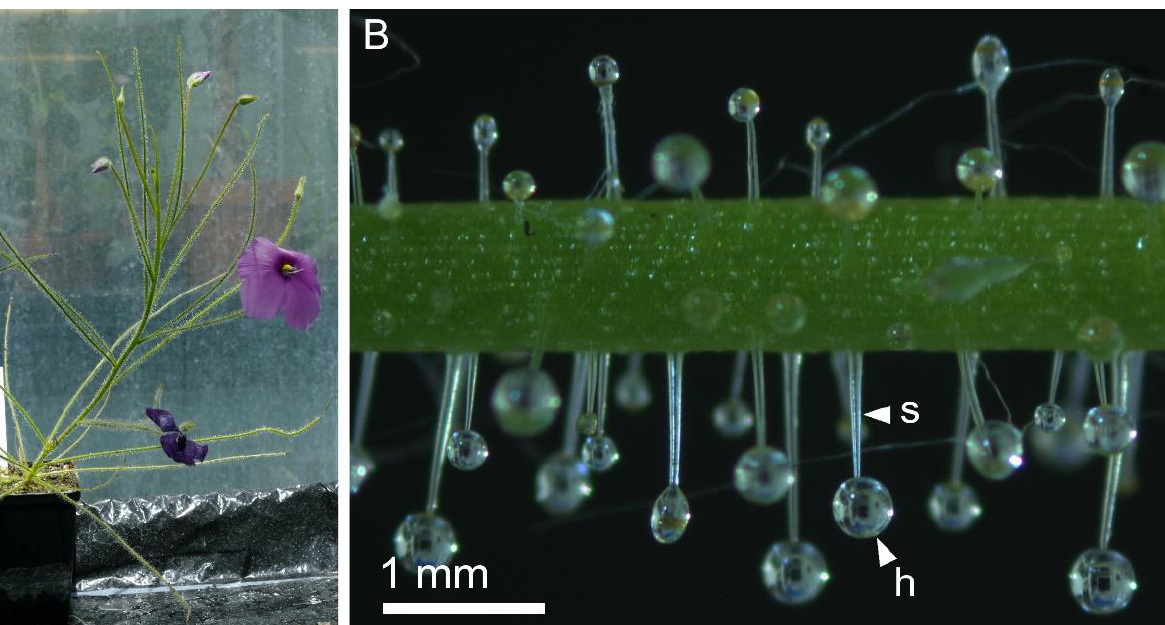
Figure 1. B. gigantea in cultivation. ( A ) A flowering plant. ( B ) Detail of a trap leaf. The lower leaf surface shows a higher stalked gland density than the upper surface. The stalk cell (s) and head (h) with a glue drop of a single stalked gland situated on the lower leaf surface are indicated.